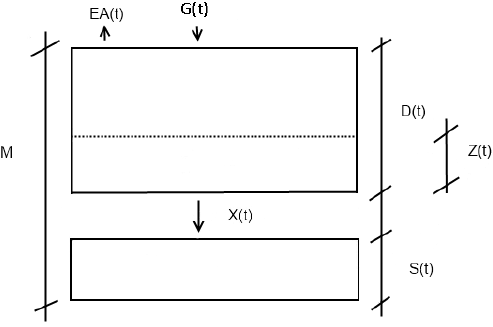
Figure 1. Schematic of the subsurface water reservoir M of DDD. G(t) represents moisture input, rain and snowmelt. The dotted hor- izontal line is the actual level, Z , of soil moisture in D . The ratio ( G(t) + Z(t) )/ D(t) controls the release of excess water to S and hence to runoff. Note that D , S and Z are functions of time, whereas M is